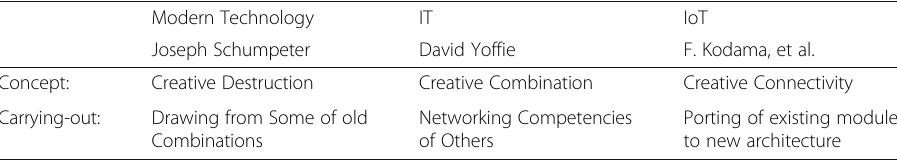
Table 2 Comparison of perspectives on